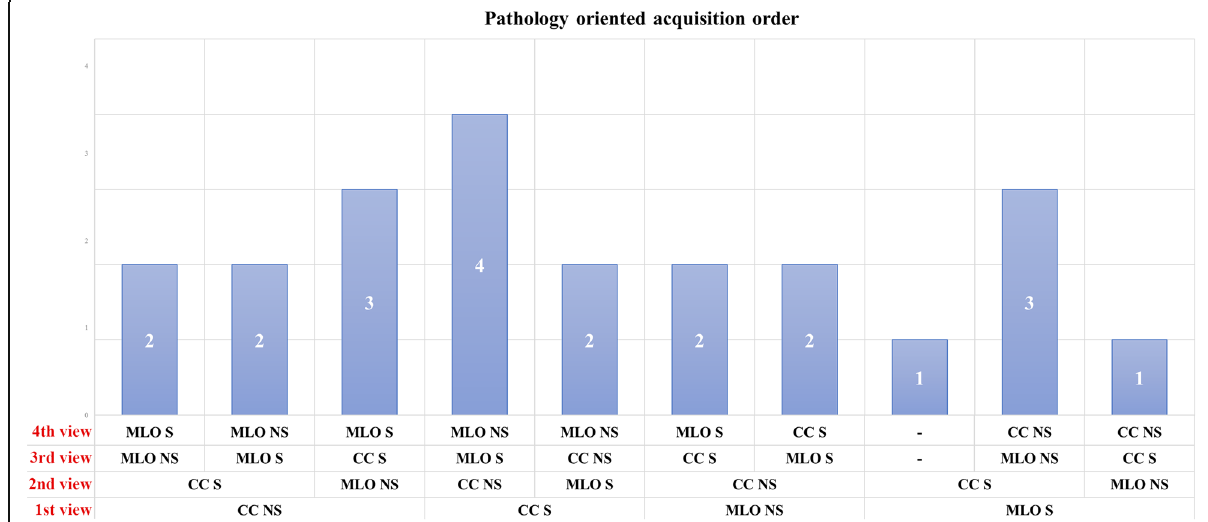
Fig. 4 Graphical summary of pathology-oriented view acquisition orders for contrast-enhanced spectral mammography: CC craniocaudal view, MLO mediolateral oblique view, S suspicious breast, NS not suspicious